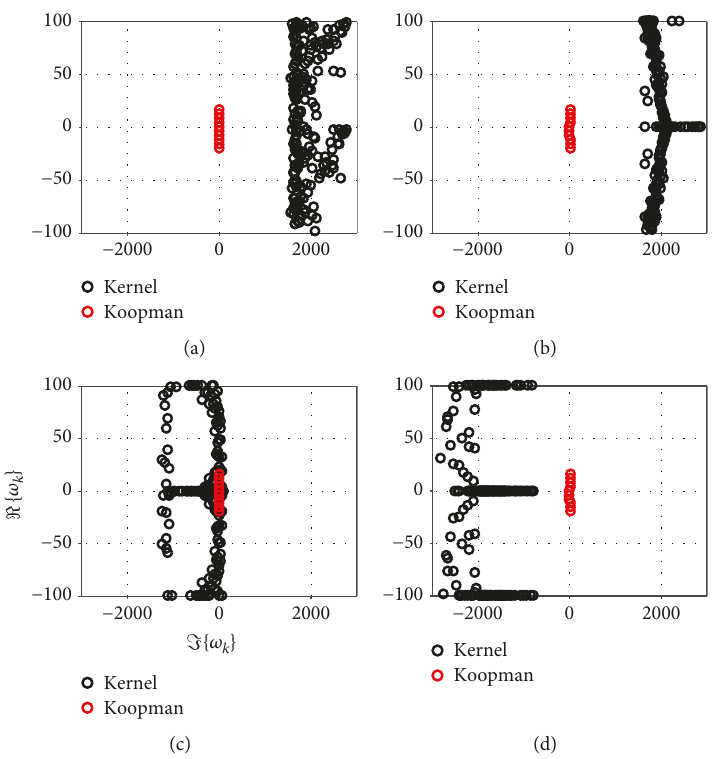
Figure 5: (a) – (d) Koopman spectra of the four kernels considered in (37) and (38a) – (38c), respectively. The red spectra are the Koopman spectra generated from the rank r = 10 observable g x which provides an exceptionally accurate reconstruction of the NLS 1